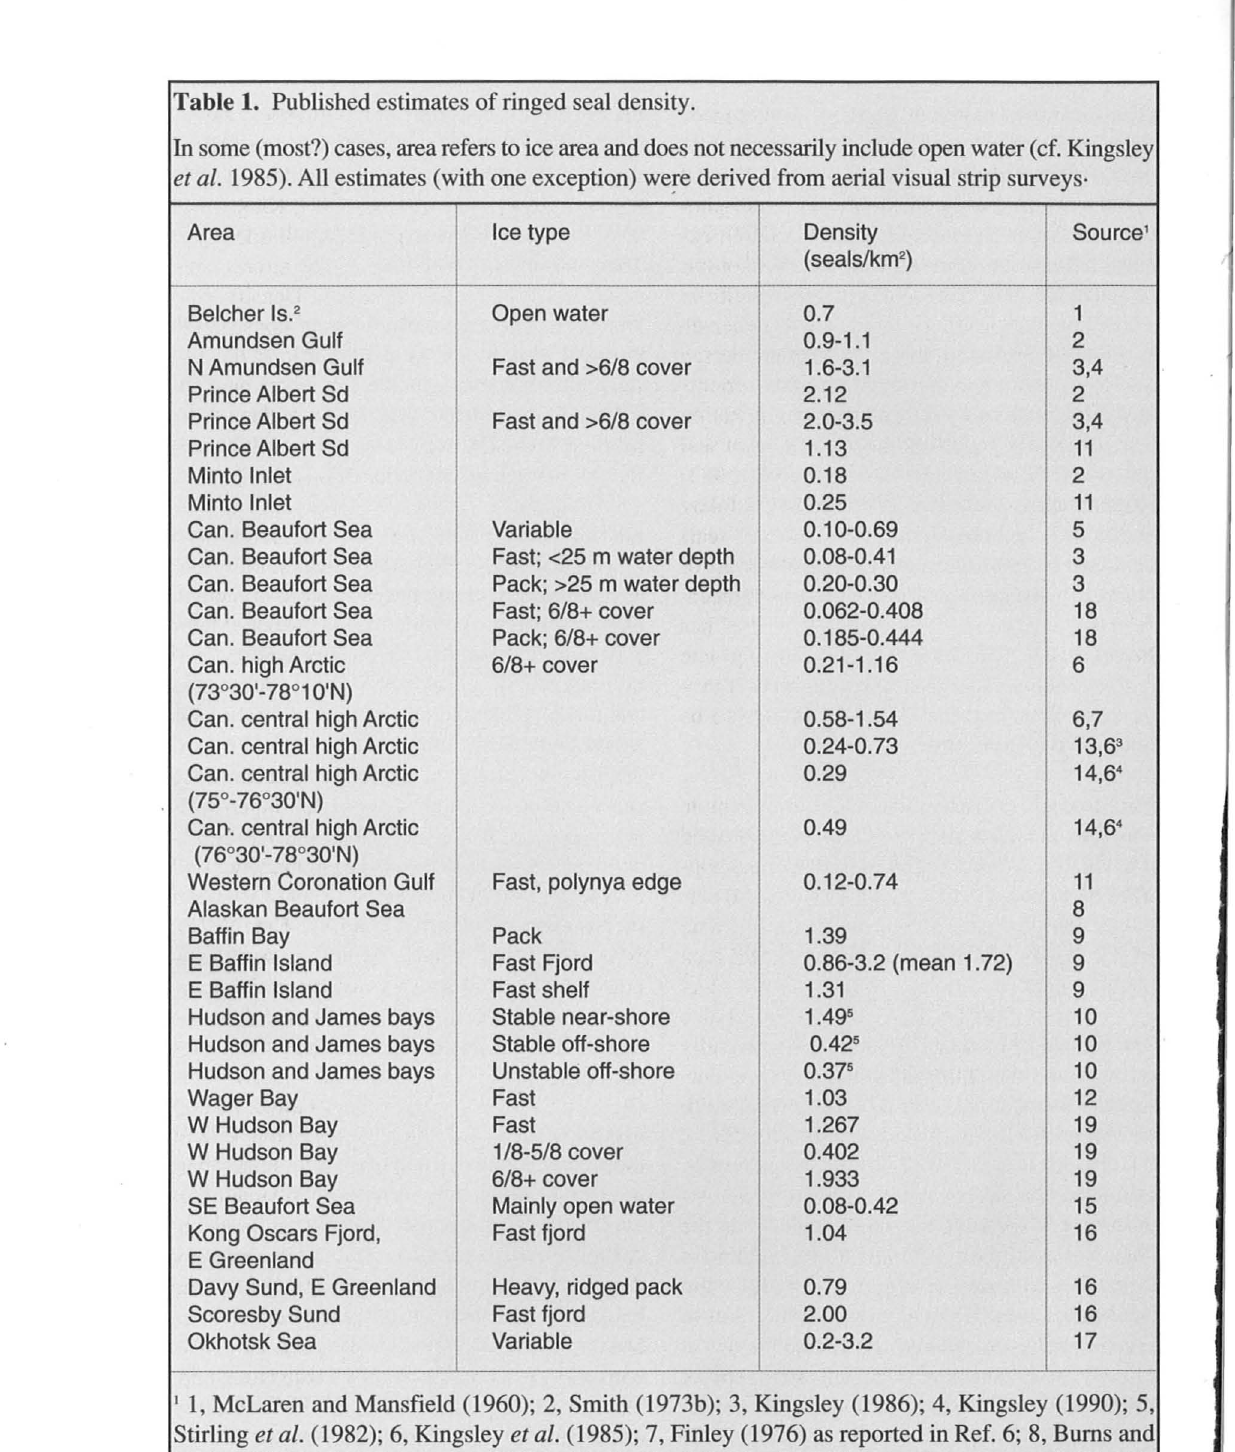
Table 1. Published estimates of ringed seal density. In some (most?) cases, area refers to ice area and does not necessarily include open water (cf. Kingsley et al. 1985). All estimates (with one exception) were derived from aerial visual strip